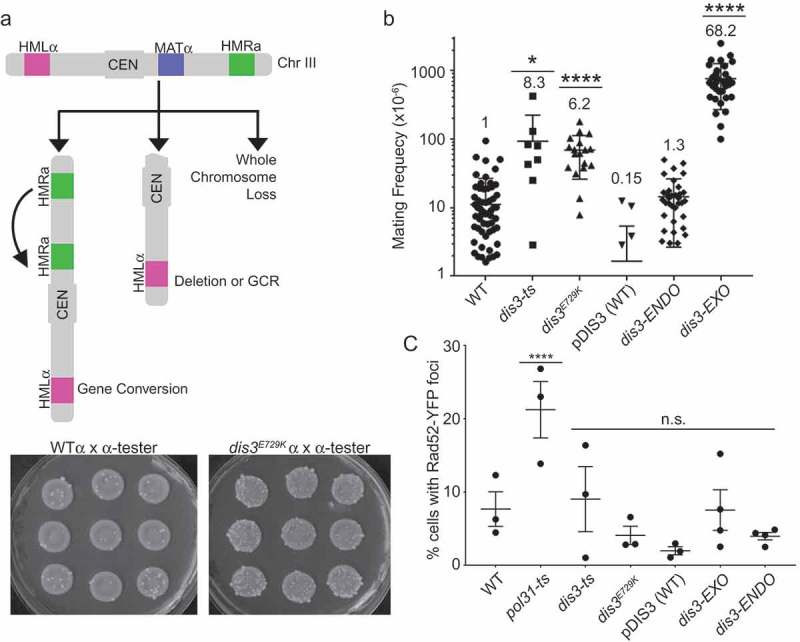
Mutations in the DIS3 exonuclease domain cause genome instability. (a) Schematic of ALF assay. Chromosome III has active (MAT) and silent mating loci (HMR, HML). Loss of MAT by gene conversion, deletion or whole chromosome loss leads to α-α mating. Sample images of nine independent mating rate tests in WT or dis3E729K are shown below. (b) Observed frequencies of mating in ALF assay for indicated strains. The fold increase over WT is shown above each dot plot. (c) Quantification of Rad52-YFP foci formation in DIS3 mutants. For B, data were compared with a Kruskal-Wallis Test. For C, Fisher’s Exact Test was used on raw count data. *p < 0.05, ****p < 0.0001.